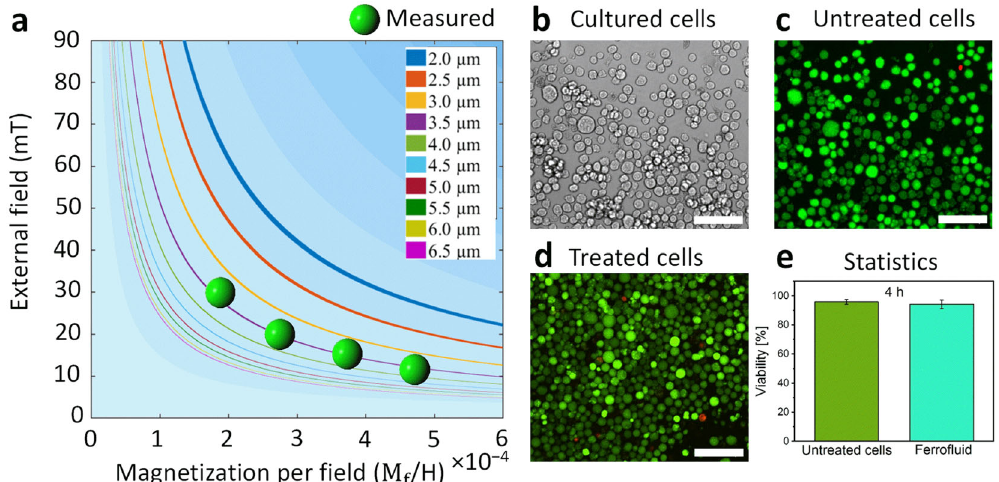
Fig. 4 Varied magnetic fi eld strengths depending on ferro fl uid magnetization per fi eld and the analysis of cell viability with and without the presence of ferro fl uid. a Plot of magnetic fi eld strength and different ferro fl uid magnetization per fi eld ( M f = H ) for PsD hole movement for various particle sizes. The line interval corresponds to the 0.5 µ m radius of the PsD hole. Smaller size PsD holes require higher magnetic fi elds and magnetizations. b , c Differential interference contrast (DIC), live (green) and dead (red) fl uorescence images of THP-1 cells in the cell culture medium without ferro fl uid treatment. d Live and dead fl uorescence images of THP-1 cells after 4 h of treatment with ferro fl uid. Scale bar: 100 µ m. e Quantitative analysis of the viability of THP-1 cells demonstrating no acute toxicity induced by ferro fl uid. Data are presented as the mean ± standard deviation (SD). NATURE COMMUNICATIONS| (2021) 12:3024 |https://doi.org/10.1038/s41467-021-23251-4|www.nature.com/naturecommunications